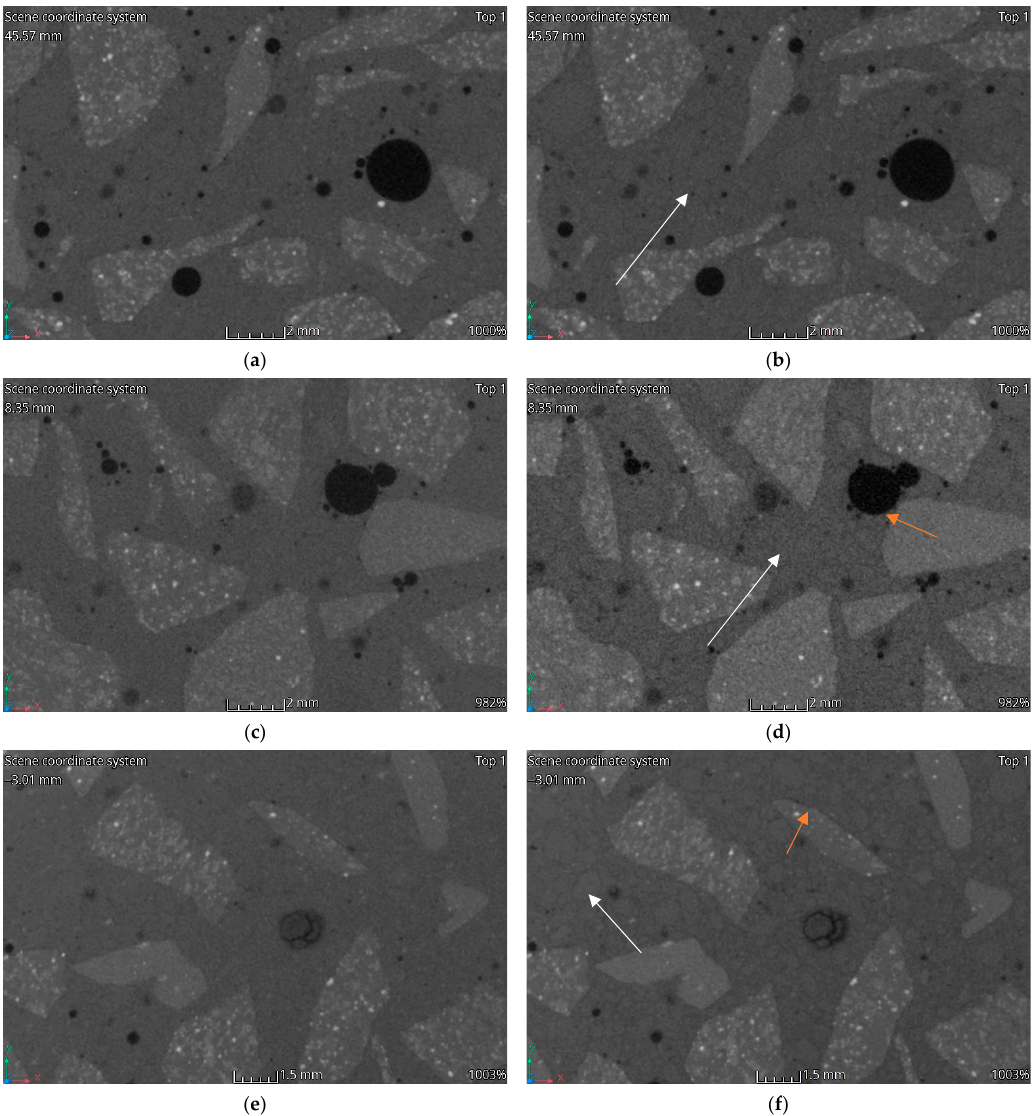
Figure 12. CT imaging results. Structural changes in three samples HPC: ( a ) 20 °C; ( b ) 200 °C; ( c ) 20 °C; ( d ) 400 °C; ( e ) 20 °C; ( f ) 600 °C.